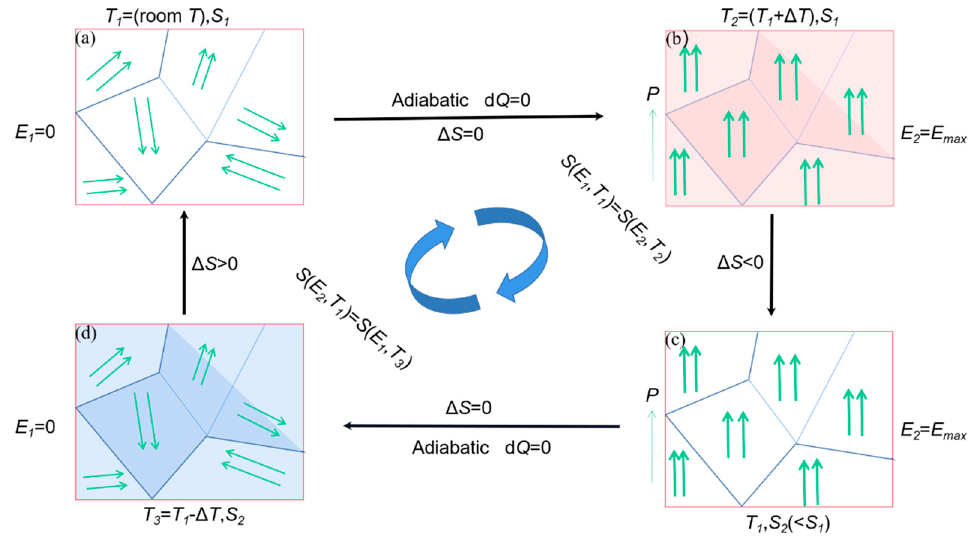
Figure 24. A schematic diagram for an EC refrigeration cycle. ( a ) The initial stage. ( b ) Adiabatic polarization stage. ( c ) Isoelectric enthalpic transfer stage. ( d ) Adiabatic depolarization stage.